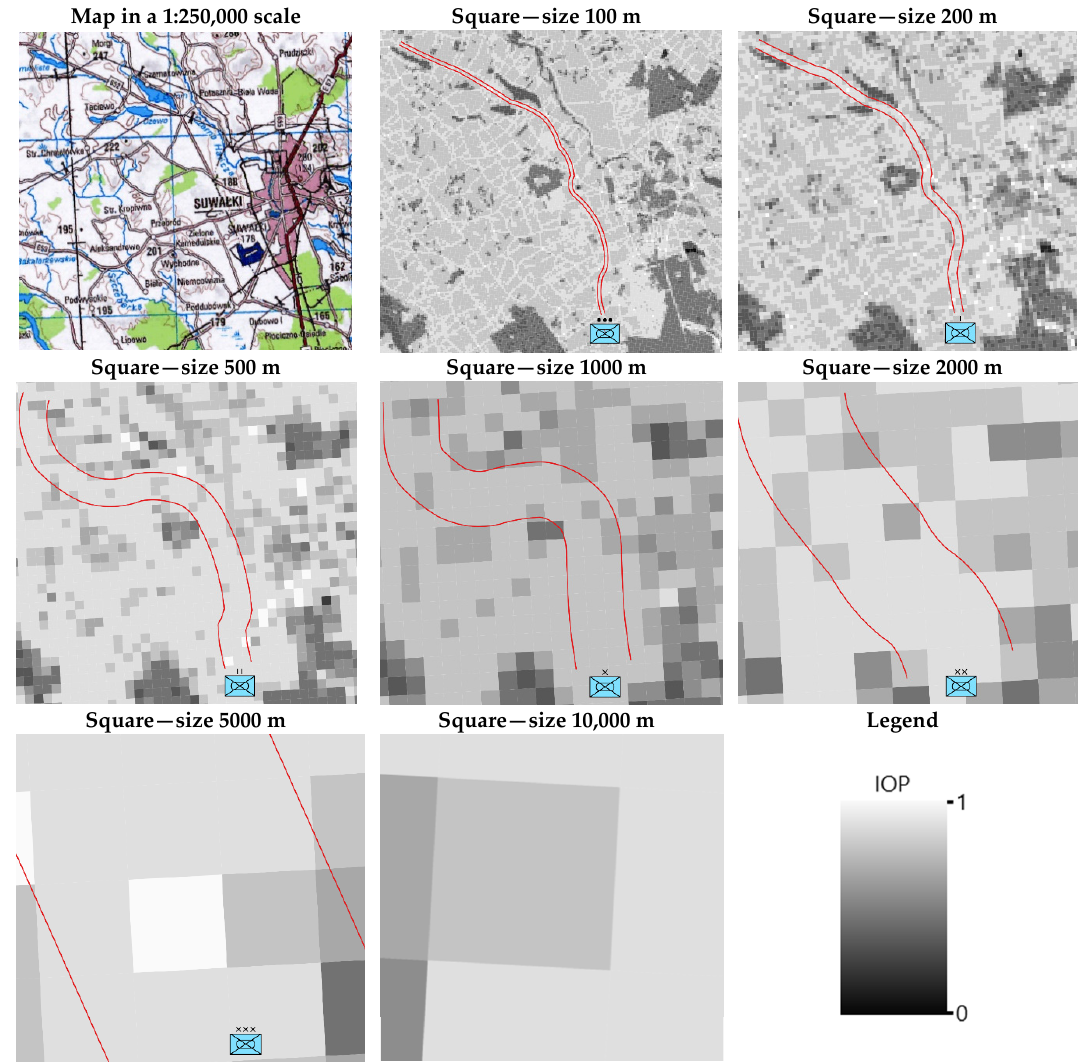
Figure 8. Fragments of passability maps for various sizes of cell. IOP—indices of passability. ISPRS Int. J. Geo ‐ Inf. 2018 , 7 , x FOR PEER REVIEW